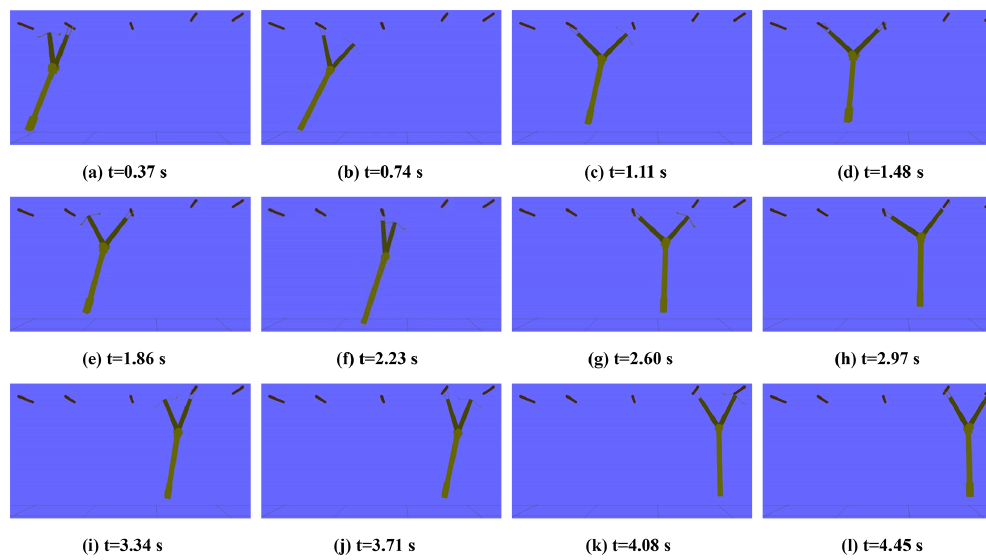
Figure 9. The continuous swing process of the brachiation robot in Gazebo.